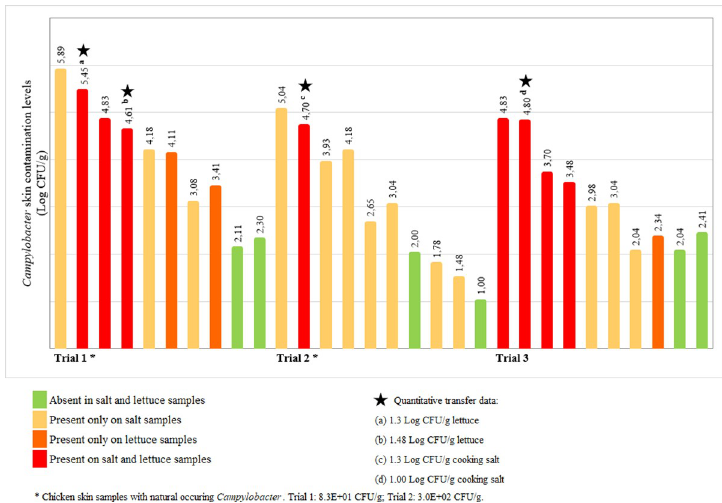
Fig 2. Transfer of Campylobacter from the contaminated chicken skin to cooking salt via unwashed hands, and from cooking salt to lettuce, according to the different initial skin surface contamination levels. The presence/ absence (qualitative transfer data) of the pathogen on salt and lettuce samples is indicated by the different colours. Quantitative transfer data (i. e. numbers of Campylobacter organisms) was achieved in four samples (a) 1.30 Log CFU/ g lettuce; (b) 1.48 Log CFU/g lettuce; (c) 1.30 Log CFU/g cooking salt; (d) 1.00 Log CFU/g cooking